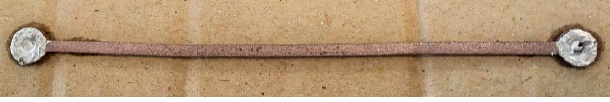
Figure 4. Printed line with Electrifi material.